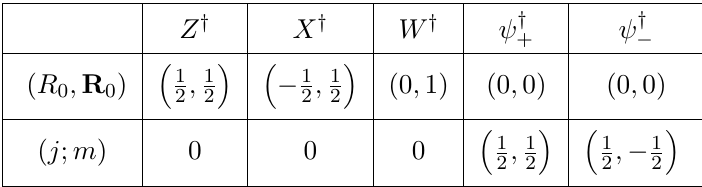
Table 1 . The charges and weight of the letters in the SU (2 data from [12]. We identify Φ † a with Z † , X † , W † respectively. Thus a = 1 , 2 , 3 will be mapped to the corresponding values of ( R 0 , R 0 )